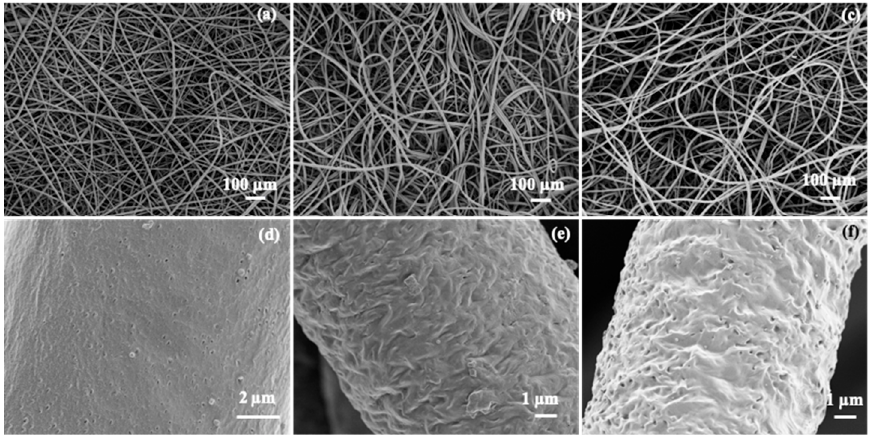
Figure 6. SEM images of plain PGl ( a , d ); crosslinked PGl / HM–bisTAD ( b , e ) and crosslinked PGl MDP–bisTAD ( c , f ).